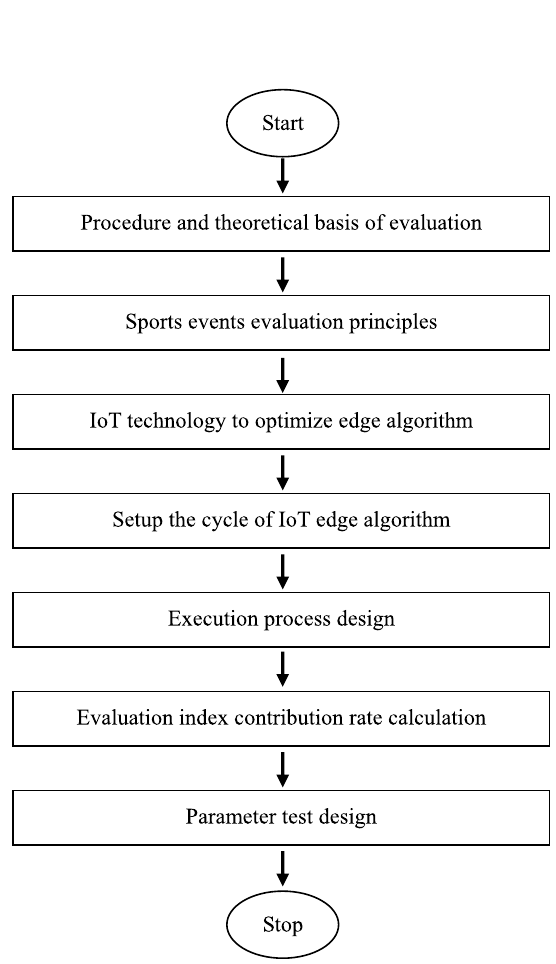
Fig. 7 Flowchart of IoT edge computing-based Sports event evaluation